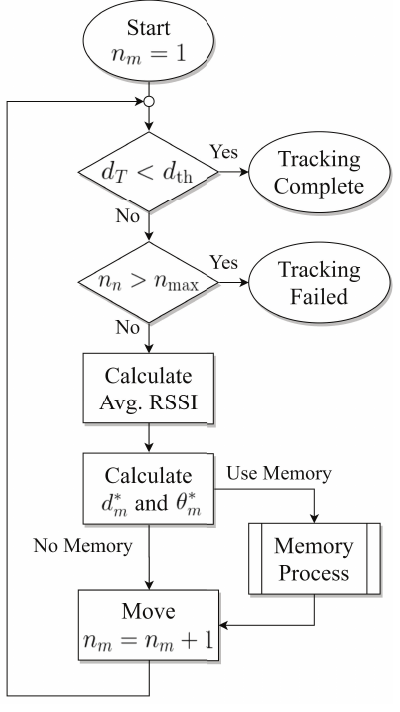
Figure 2. Tracking